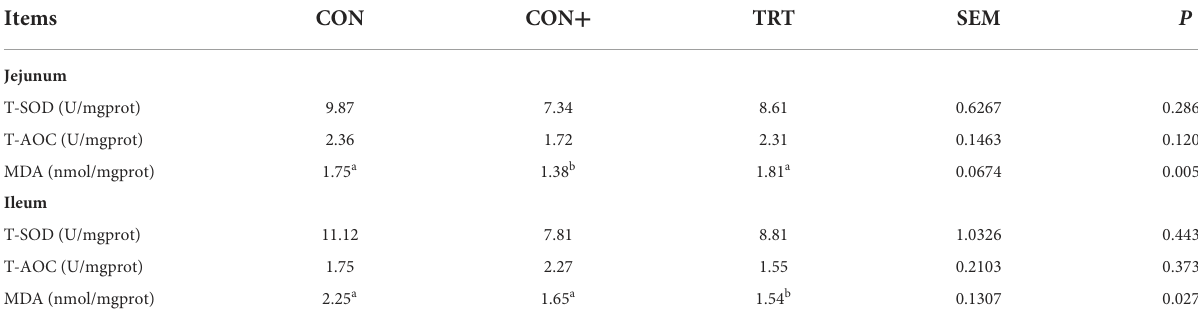
TABLE 4 Antioxidant effect of jejunum and ileum in AA broilers.